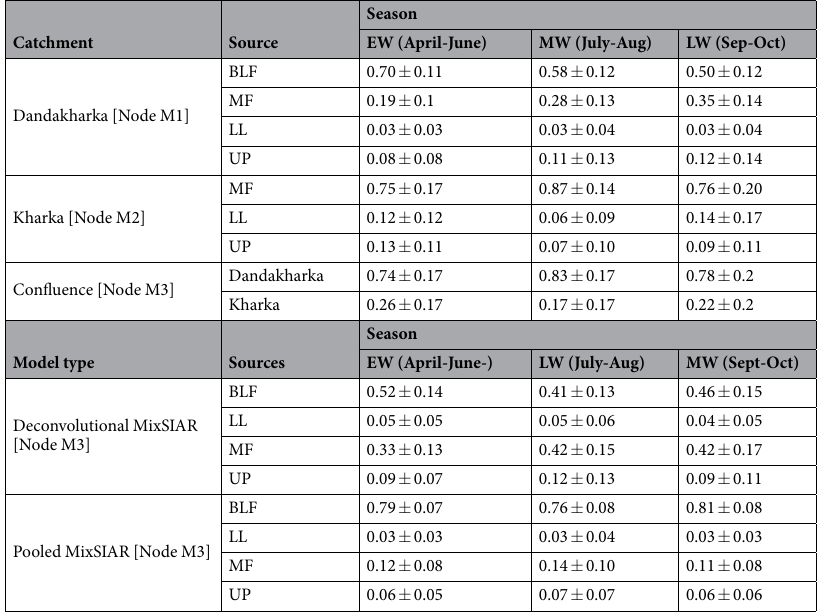
Table 4. Temporal variability in relative contributions (mean ± SD) of sediment sources within individual sub- catchment and sub-catchments contribution to sediments downstream to confluence using MixSIAR node-by- node i.e. the raw ingredients of the D-MixSIAR prior to deconvolution. (Seasons: EW = early wet, LW = late wet and MW = mid-wet and sources: BLF = broad leaf forest, MF = mixed forest, LL = lowland, and UP = upland) (b) pooled MixSIAR versus D-MixSIAR relative contributions for node